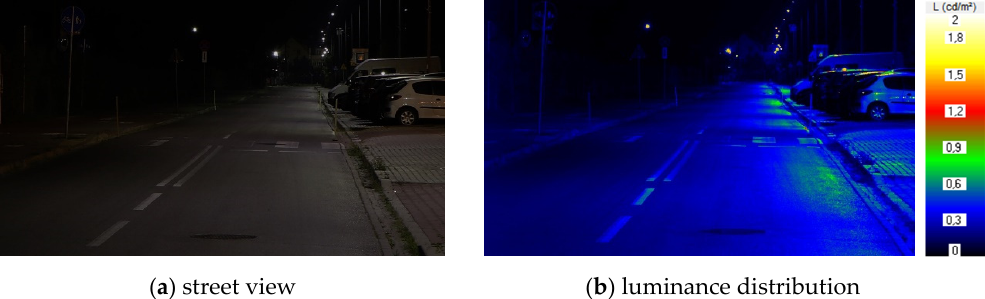
Figure 21. View of the street with lighting when the luminous flux Φ of the lamps is controlled to 40% (average luminance of the roadway is Lav = 0.30 cd/m 2 ).